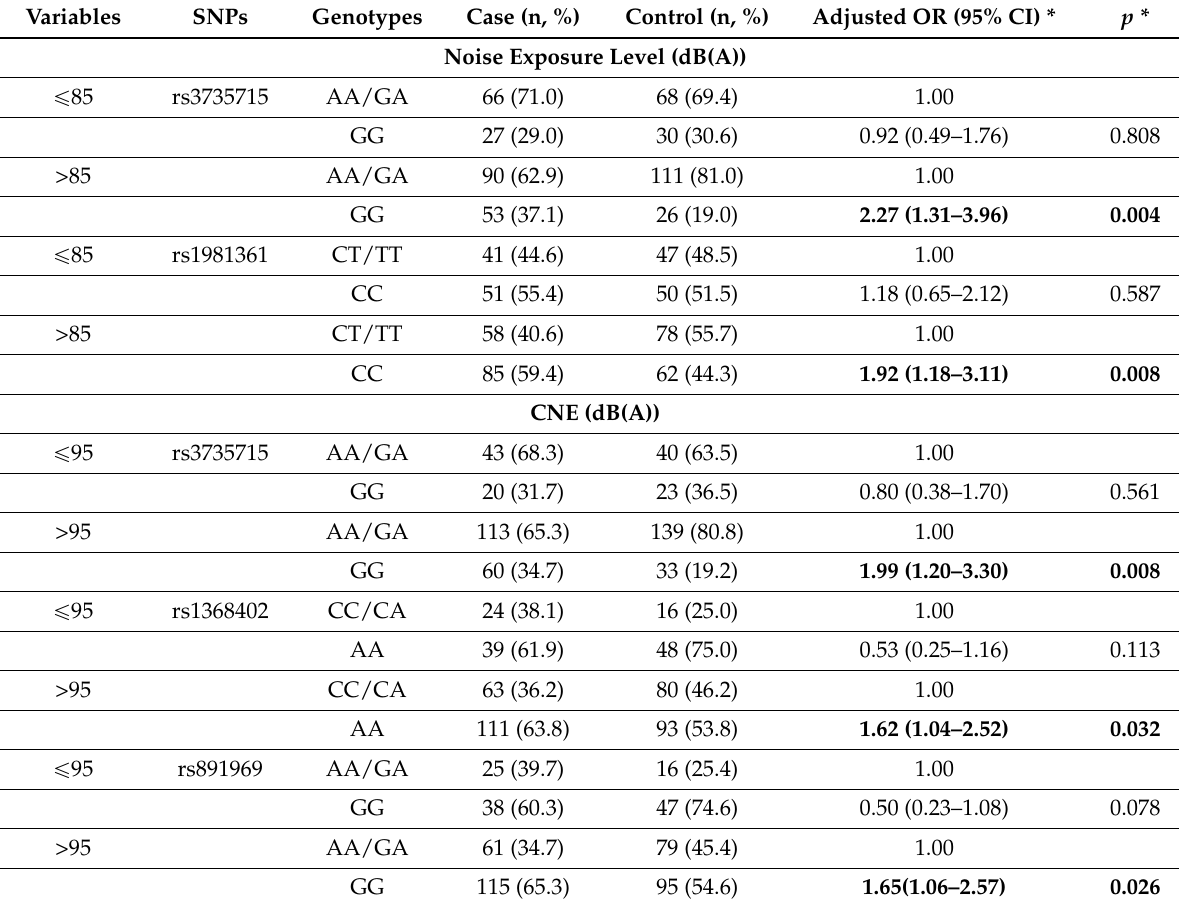
Table 3. Stratified analysis of associated SNPs by noise exposure level or